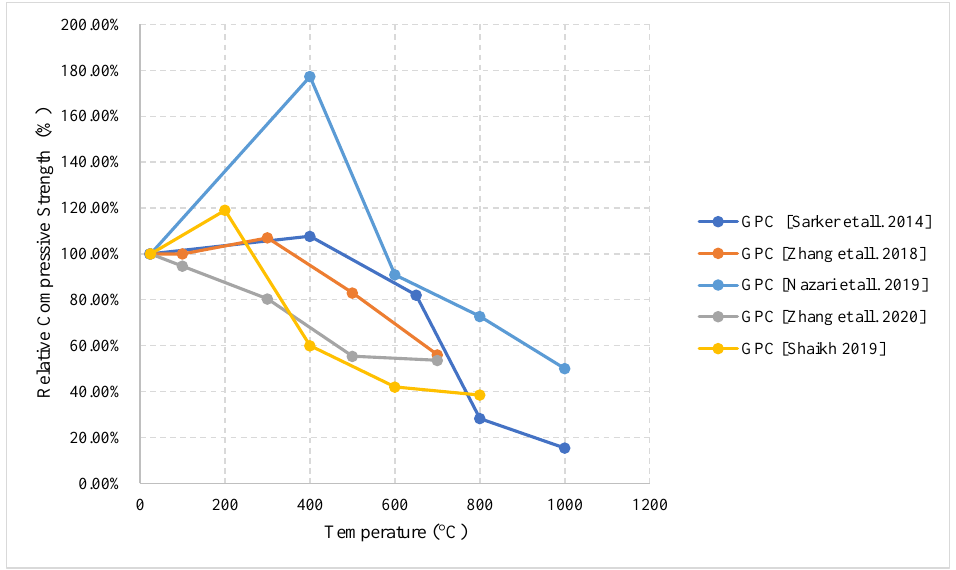
Figure 37. Relative compressive strength of naturally cooled GPC with different constituents [39,43,44,117,118].